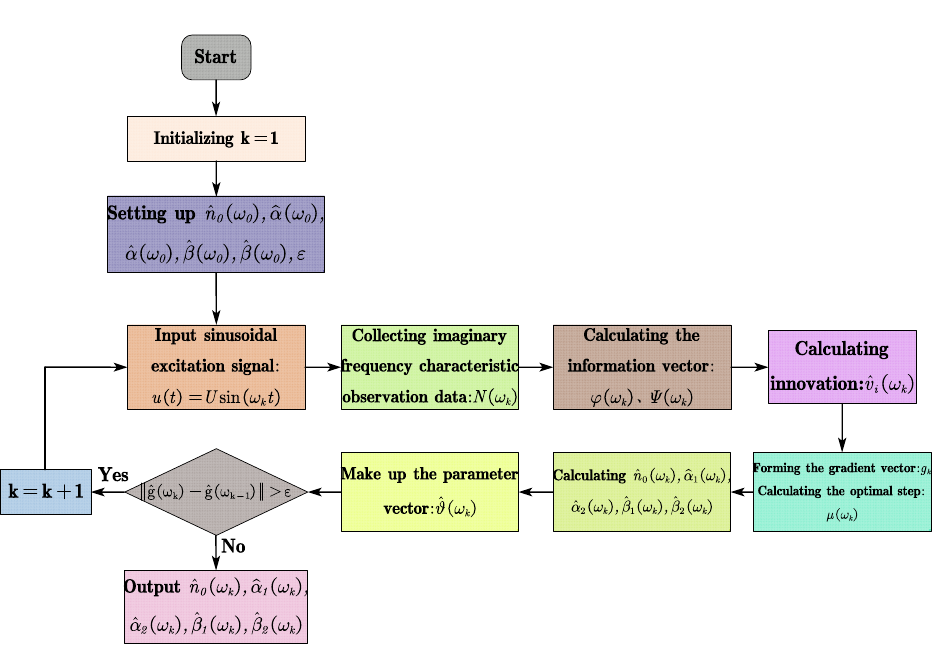
Figure 6. Flow chart of parameter estimation of the system transfer function.